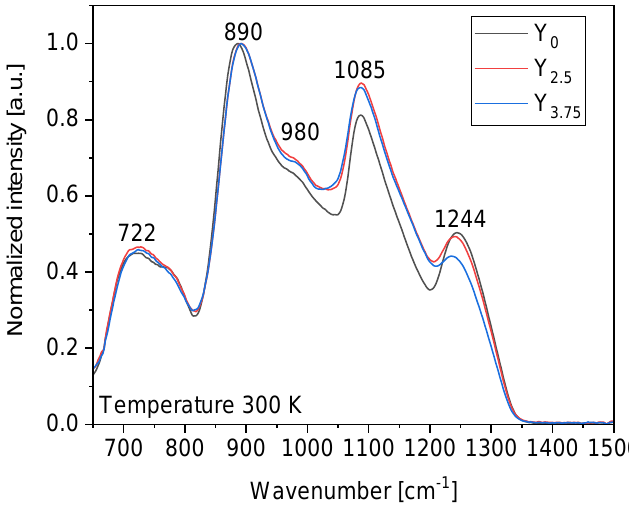
Figure 3. The IR spectrum of the investigated glasses. An increase in the intensity of the band at 1085 cm − 1 and a decrease in the intensity of the band at 1250 cm − 1 can be observed with an increase in the Y 2 O 3 content, indicating that the addition of Y 2 O 3 to the network leads to a progressive depolymerization of the phosphate network associated with an increase in the Q 1 units at the expense of Q 2 units. One can notice that the bands shift towards higher wavenumbers with an increase in the Y 2 O 3 content, which is a clear sign of changes in the chemical bonds’ strength in the glass network.